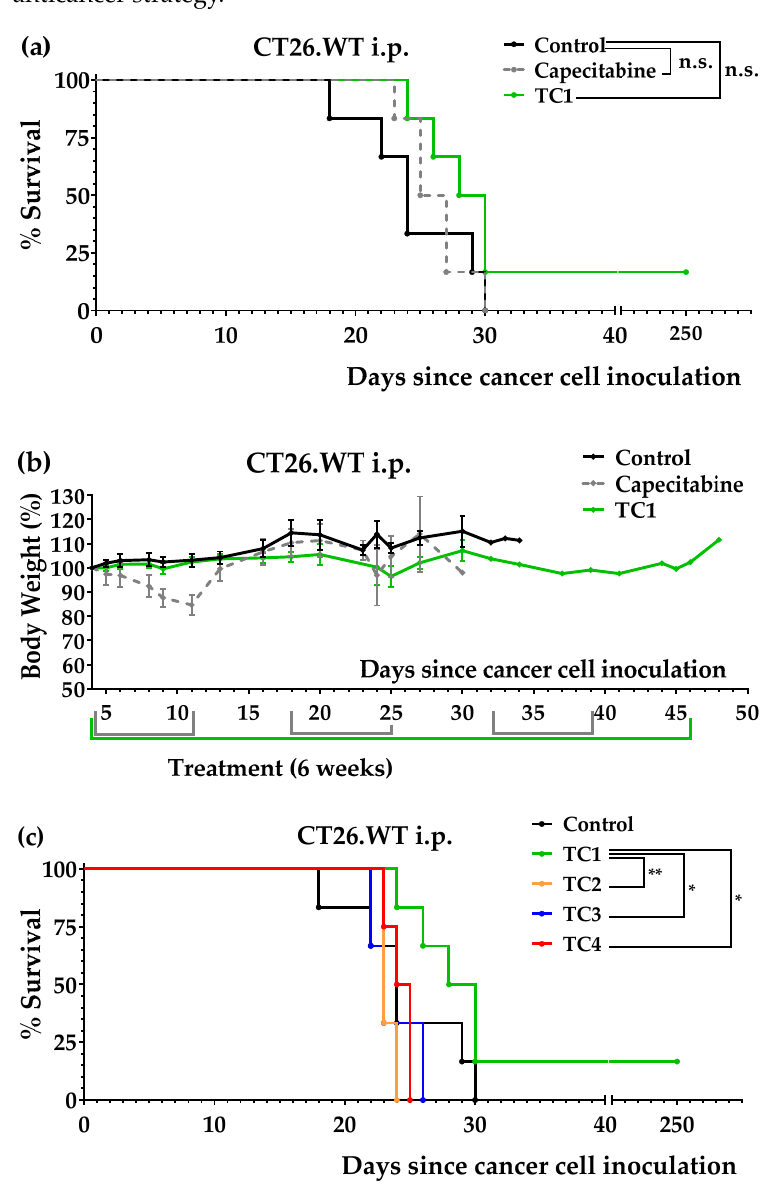
Figure 3. Anticancer activity of diets TC1, TC2, TC3, TC4, and capecitabine in mice with colon cancer (CT26.WT murine colon cancer cells inoculated in the peritoneum of immunocompetent BALB/c mice; peritoneal dissemination model). ( a ) Survival of the untreated mice (control), the mice treated with diet TC1 (normal diet was replaced by the TC1 diet for 6 weeks), and the mice treated with oral capecitabine (450 mg/kg/day, 7/7 schedule, 3 cycles). ( b ) Mice body weights (mean percentage ± SEM) relative to the body weights at the beginning of the treatments (day 4). ( c ) Comparison of survival of the mice fed with diets TC1, TC2, TC3, and TC4 over 6 weeks. The p -values were calculated with the GBW test; * indicates p < 0.05, and ** indicates p < 0.01. n.s. means no Diets TC2, TC3, and TC4 were also tested in this colon cancer model. As shown in Table 2, diet TC2 was diet TC1 plus 0.2% Cys, diet TC3 was diet TC1 plus 0.2% Cys and a reduction in Leu levels, and diet TC4 was diet TC1 plus 0.2% Cys and a small reduction in Met levels. All three diets were completely inactive in the mice with colon cancer; the mice fed diet TC2 diet lived 23.3 ± 0.3 days, the mice fed diet TC3 lived 23.7 ± 1.2 days, and the mice fed diet TC4